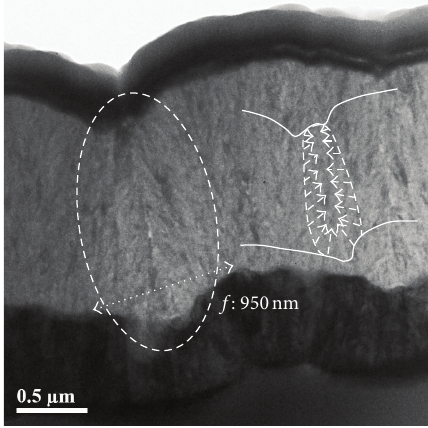
Figure 9: Measured crack or defective area formation (XTEM images) above deep valleys (“kinks”) induced by the AIT